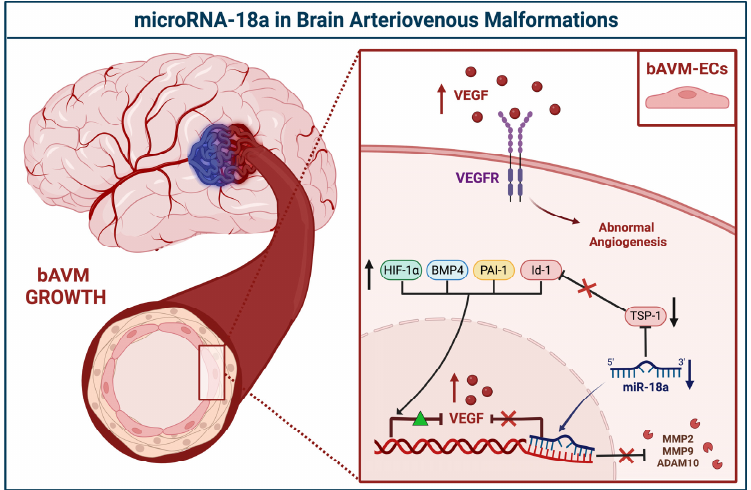
Brain Sci. 2022 , 12 , x FOR PEER REVIEW